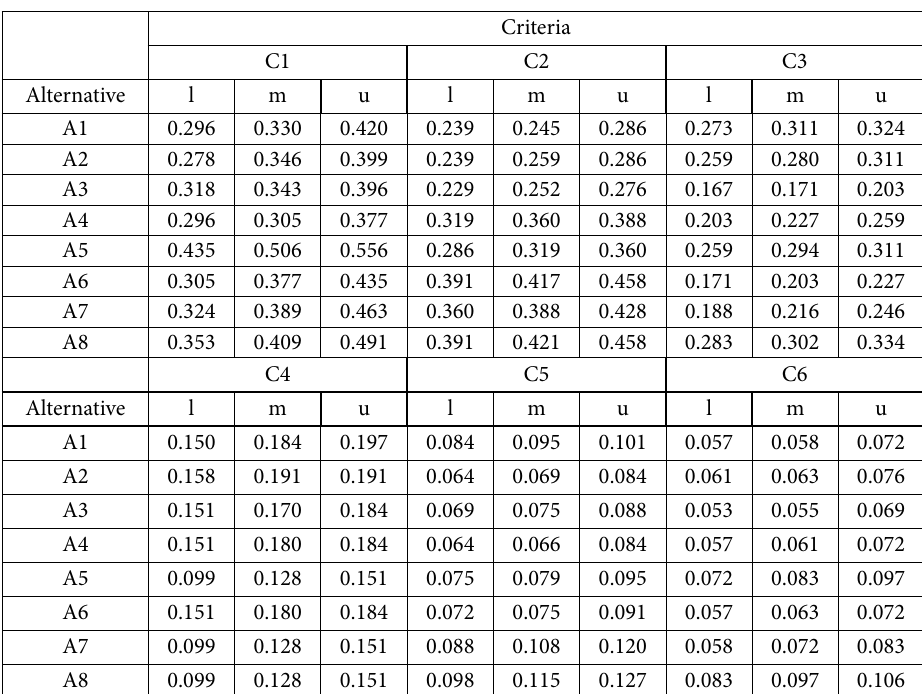
Table 10. Weighted normalized fuzzy decision